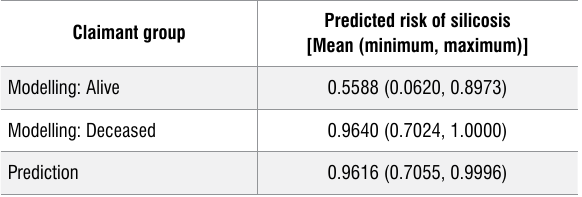
Predicted risk of silicosis [Mean (minimum, maximum)]